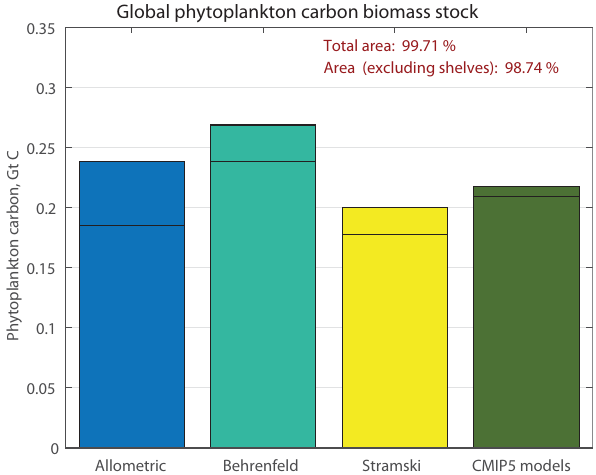
Figure 2. Global spatially integrated mixed-layer phytoplankton carbon biomass stock (GtC), as estimated with three different satel- lite algorithms (as in Fig. 1a–c) from the SeaWiFS mission com- posite and from the CMIP5 model ensemble mean (Fig. 1d), using the same climatological MLD estimate for all estimates. Horizon- tal black lines within each bar on all panels represent the estimate when continental shelves (<200m depth) are excluded. The sum of the areas of valid pixels used in the estimates is given as a percent- age of total ocean area (3.608 × 10 8 km 2 ) and area excluding the shelves ( ∼ 3.4 × 10 8 km 2 ) ,